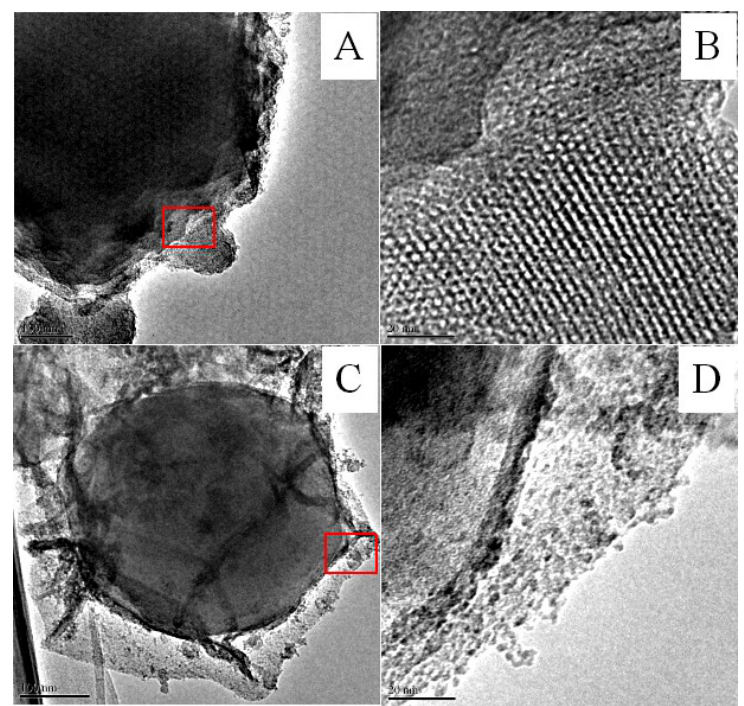
Figure 3. HRTEM images of SiO 2 @CAT/ZIF-8 ( A , B ) and Fe 3+ -CA@CAT/ZIF-8 ( C , D ).